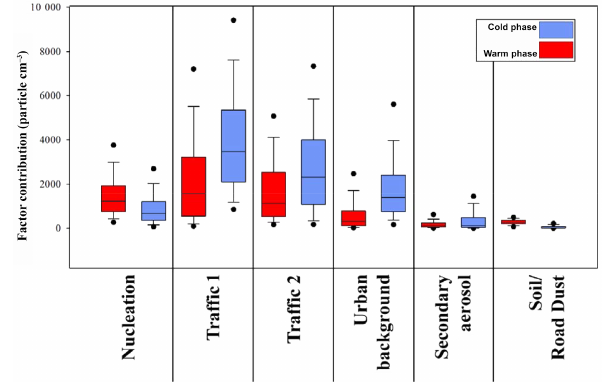
Figure 6. Contribution (particlescm − 3 ) of each of the PMF- resolved factors to the total number concentrations in the cold and warm